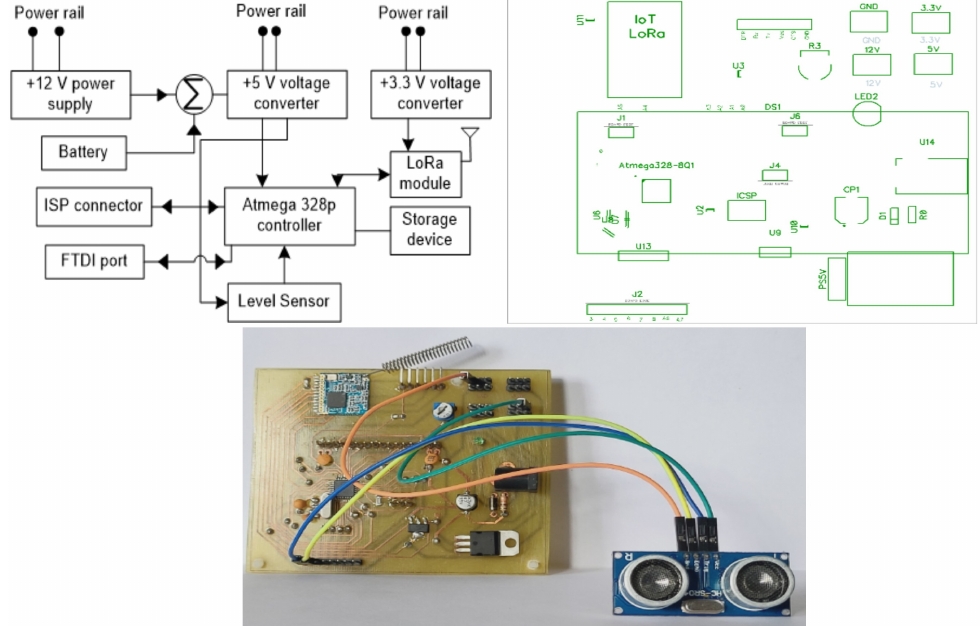
Figure 2. Sensor